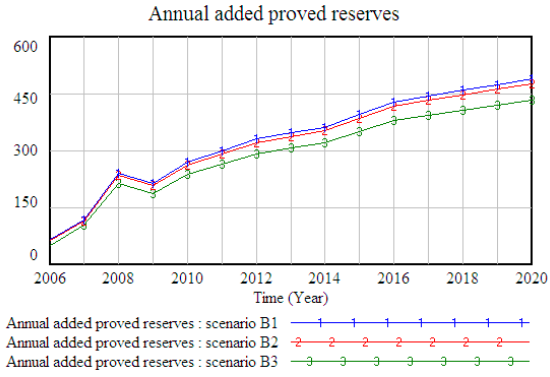
Figure 6. The proportion of development investment.